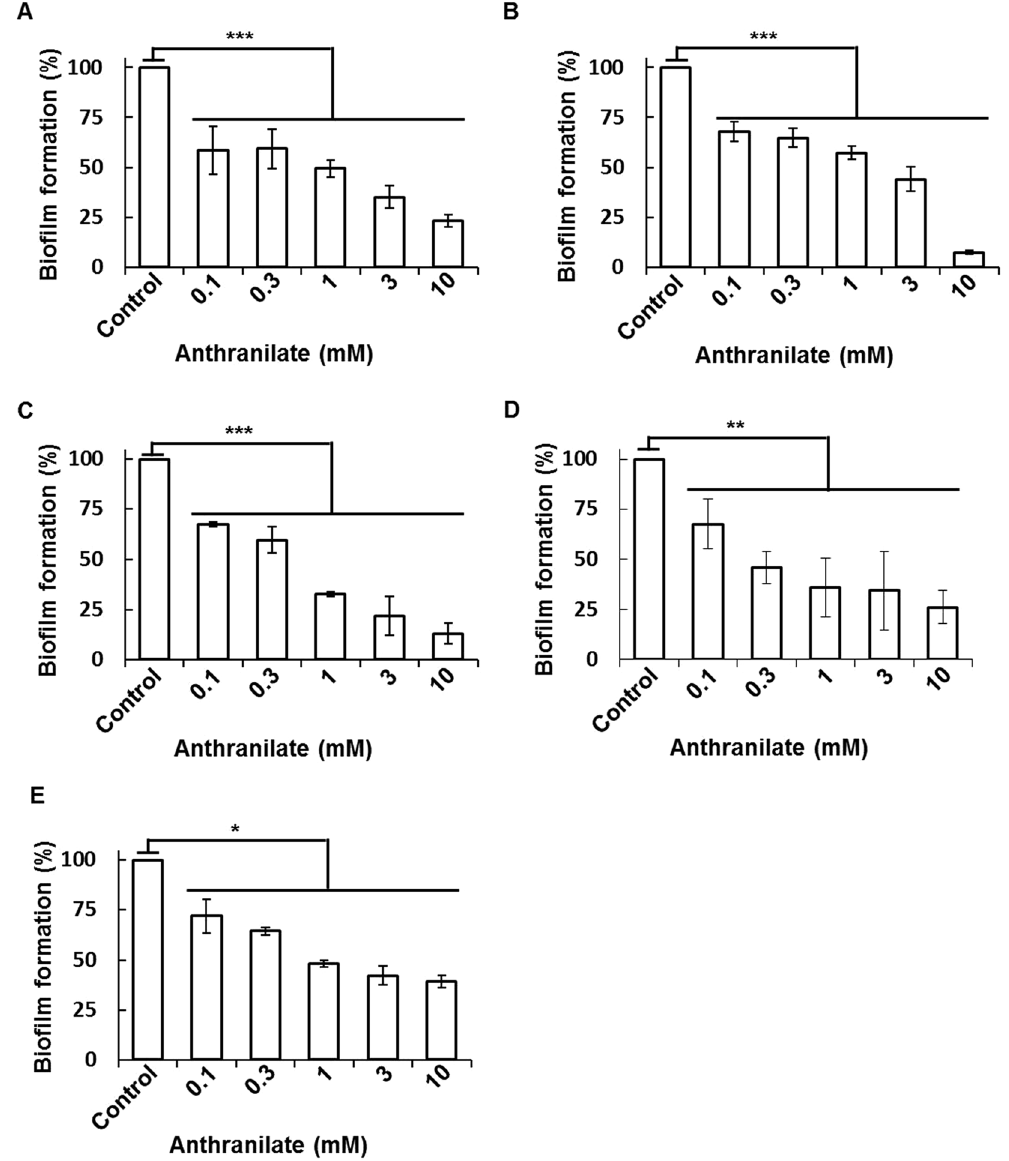
Figure 3. Strong inhibition of biofilms by high concentration of anthranilate P. aeruginosa ( A ), V. vulnificus ( B ), B. subtilis ( C ), S. enterica ( D ), and S. aureus ( E ) were treated with high concentration of anthranilate and biofilm formations were quantified by static biofilm analysis. Results are presented as percentages of the